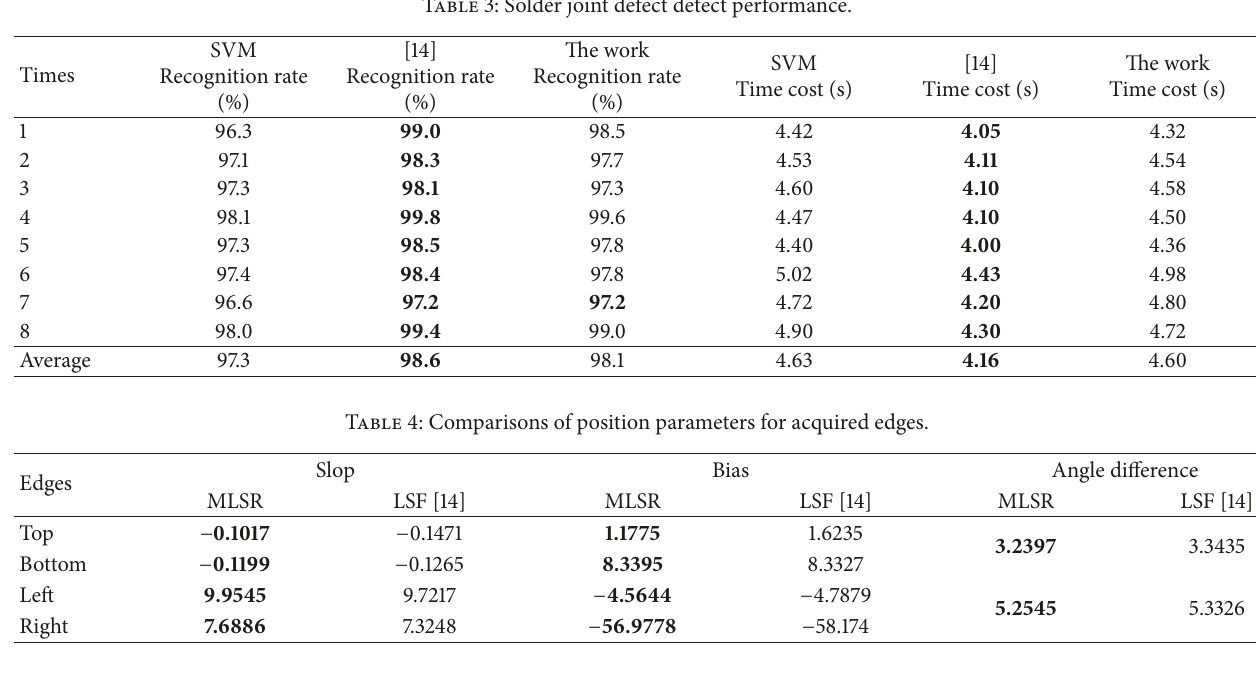
Table 3: Solder joint defect detect performance.